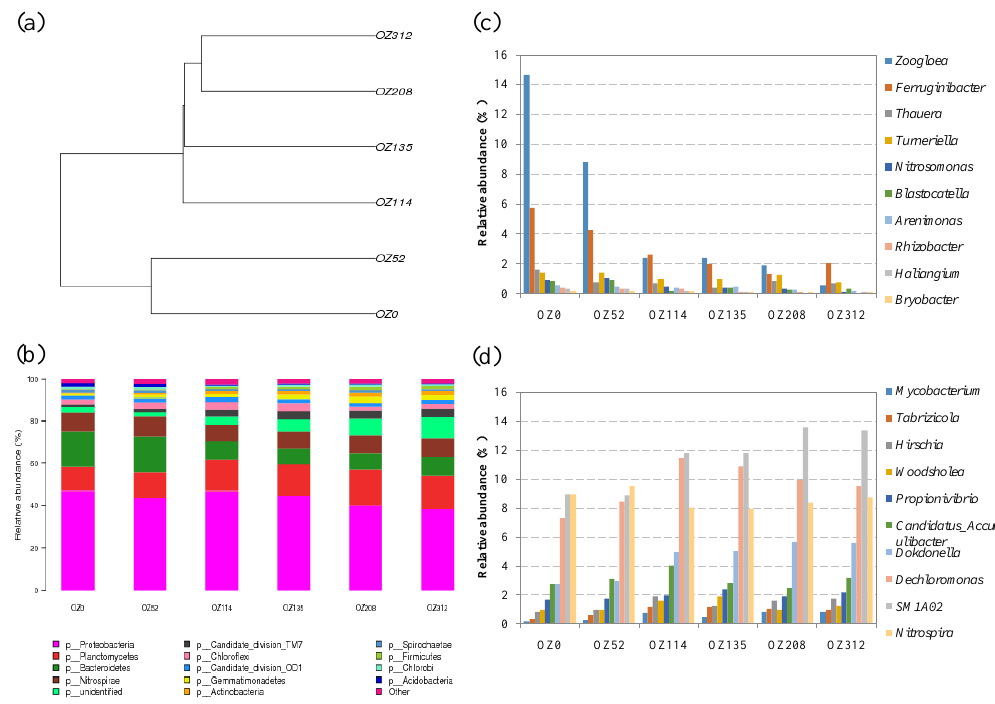
Figure 4. Succession of viable bacterial population: ( a ) Hierarchical cluster analysis of six bacterial communities. The analysis is the clustering of all OTUs (3% distance). Sample communities were clustered based on the average linkage method. ( b ) Bacterial community structures at the phylum level in the sludge samples monitored using Miseq sequencing. Relative abundance was defined as the number of sequences affiliated with that phylum divided by the total number of sequences per sample. ( c ) Ten bacterial genera whose abundances decreased during ozonation. ( d ) Ten bacterial genera whose abundances increased or not changed during ozonation.